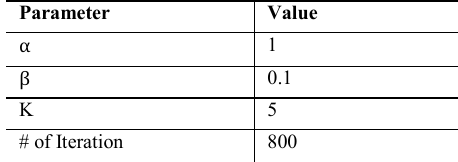
Table 3. The parameter setting in LDA.